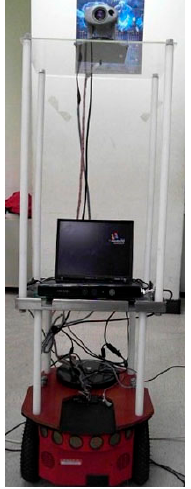
Figure 13. The experimental robot.